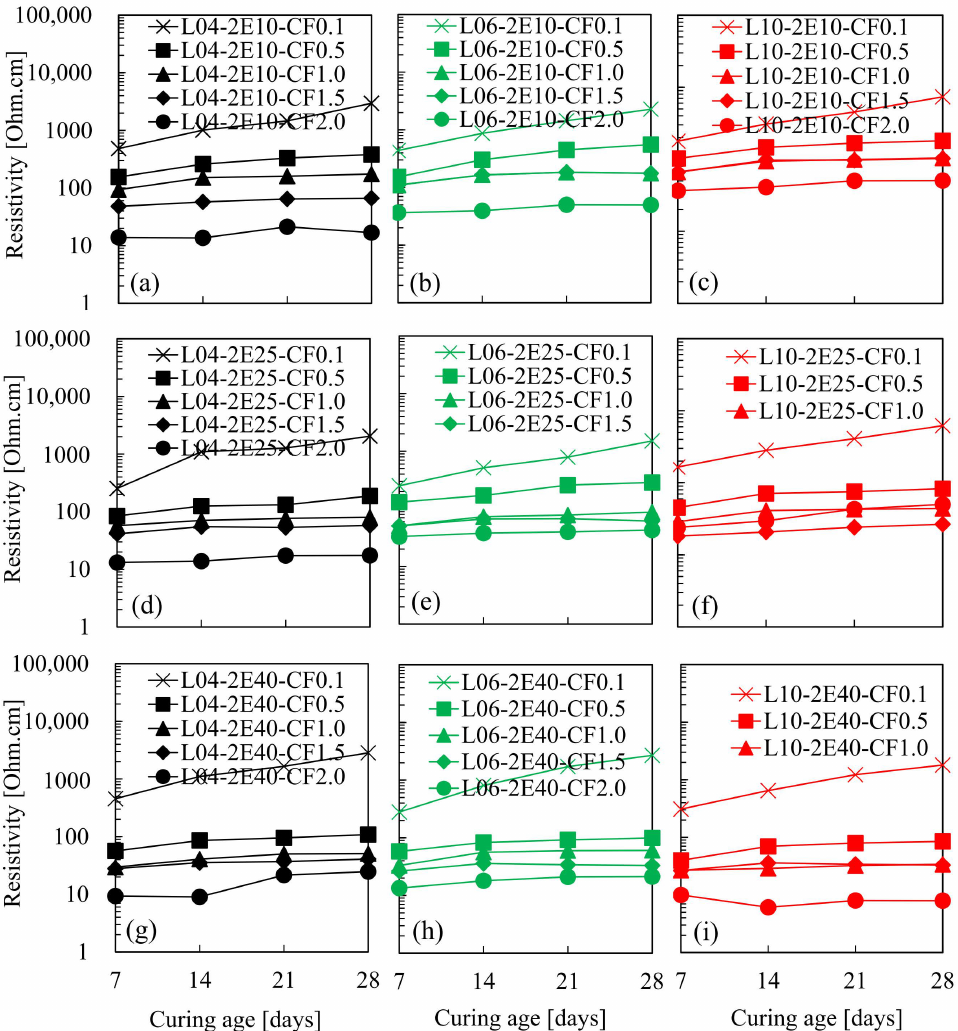
Figure 3. Variation in resistivity of cement composites as a function of the curing age for the two-probe configuration; ( a – c ) electrode spacing of 10 mm, ( d – f ) electrode spacing of 25 mm, and ( g – i ) electrode spacing of 40 mm. L04, L06, and L10 correspond to the carbon fiber (CF) lengths of 4, 6, and 10 mm, respectively. 2E10, 2E25, and 2E40 indicate the electrode spacings of 10, 25, and 40 mm, respectively. CF0.1–2.0 indicate the CF content (0.1–2%) incorporated into the cement